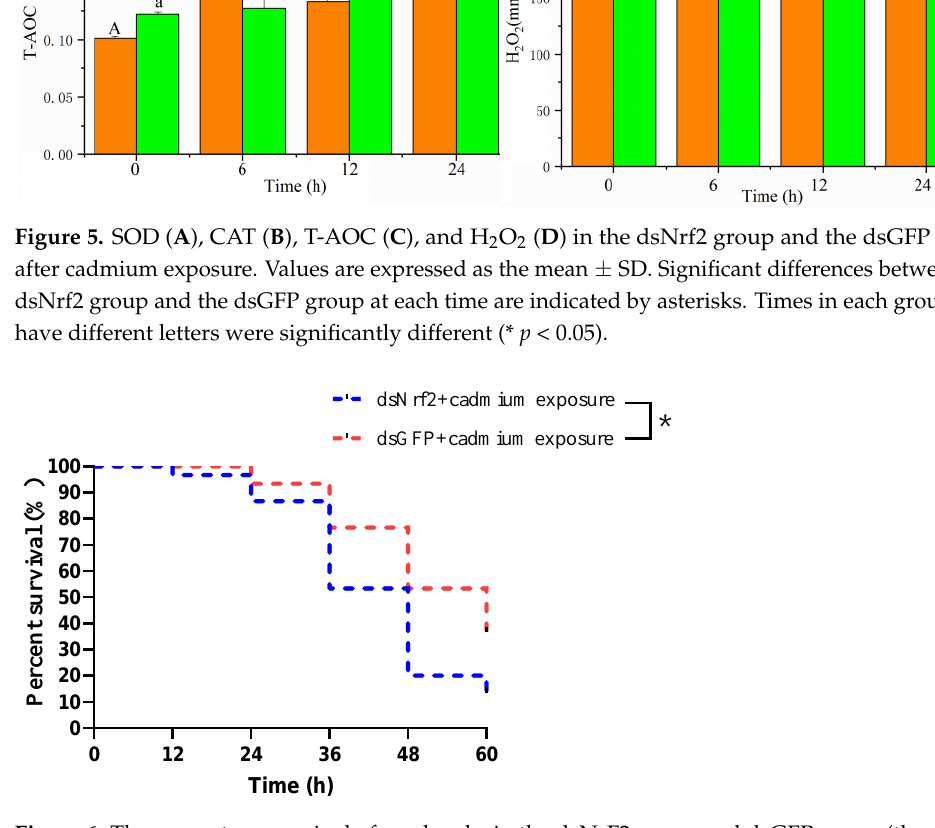
Figure 7. The molecular mechanism of the Nrf2 signaling pathway in cadmium-induced hepatotox- icity in mud crabs. 4. Discussion Cadmium, one of the most toxic heavy metals, has negative effects on aquatic ani- mals. However, the mechanisms of detoxification and antioxidant defense against cad- mium exposure in crustaceans are still unclear. The Nrf2 signaling pathway is a master regulator of cellular responses by playing a crucial role in cellular detoxification against environmental stresses. In this study, we investigated the mechanism of the Nrf2 signal- ing pathway in response to cadmium stress in mud crabs.